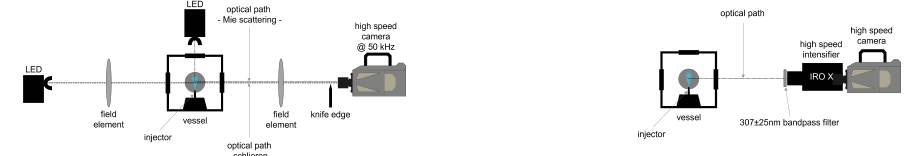
Figure 1. Experimental setup schematic: ( left ) Mie-scattering and schlieren setup. ( right ) OH*- chemiluminescence